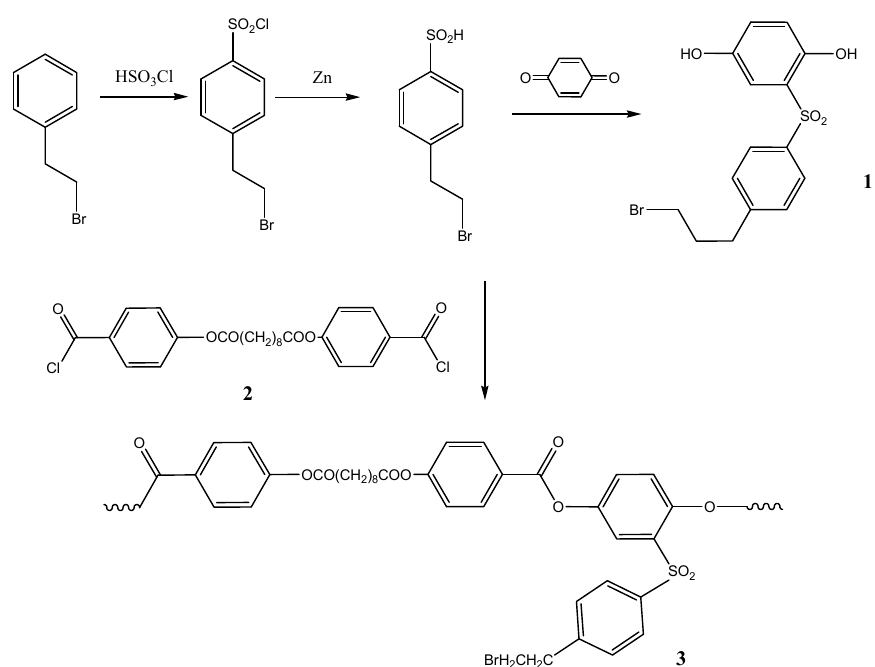
Figure 3. Synthesis route of APE ( 3 ) ie chlorosulfonation of 2-bromoethylbenzene, reduction of arenesulfonylchloride to sulfinic acid, Michael addition the latter to quinone leading to 2,5-dihydroxy-4 ′ -(2-bromoethyl)-diphenylsulfone ( 1 ) and its polycondensation with 4,4 ′ - sebacyloyldioxydibenzoyl dichloride ( 2 ).